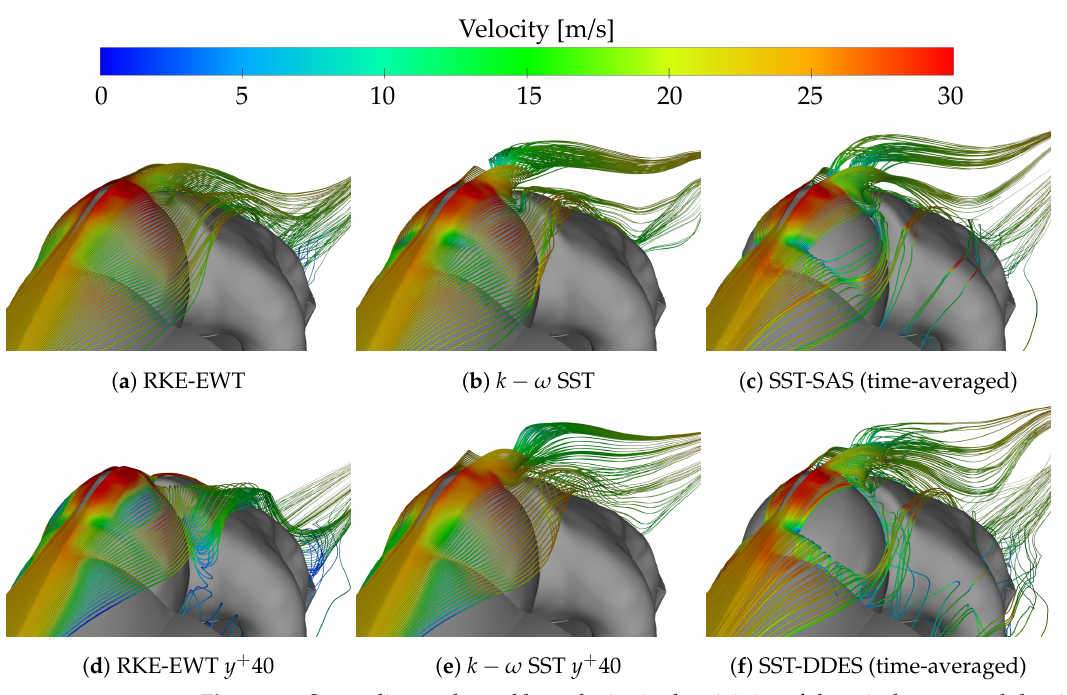
Figure 10. Streamlines coloured by velocity in the vicinity of the windscreen and the riders helmet for: ( a ) RKE-EWT, ( b ) k − ω SST, ( c ) SST-SAS (time-averaged), ( d ) RKE-EWT y + 40, ( e ) k − ω SST y + 40, ( f ) SST-DDES (time-averaged).